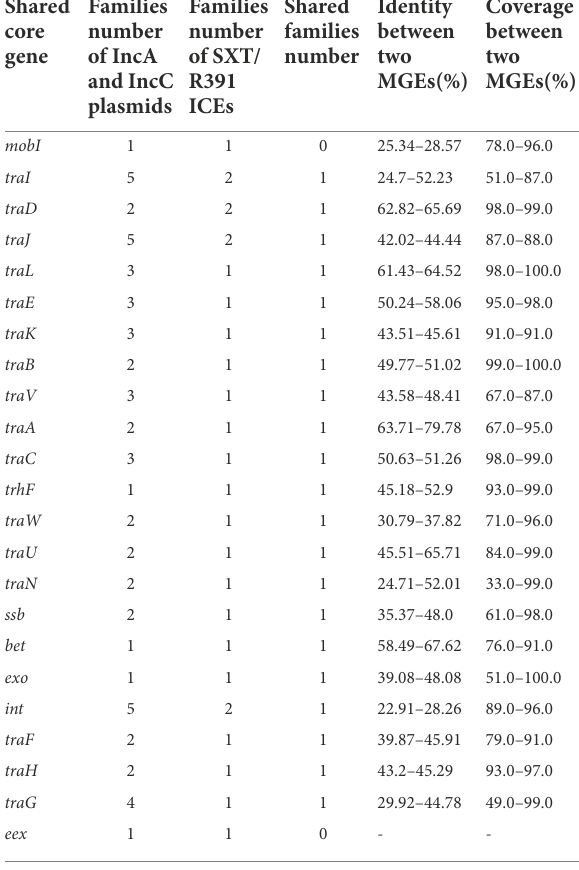
TABLE 4 Family number and similarities between shared core genes of IncA and IncC plasmids and SXT/R391